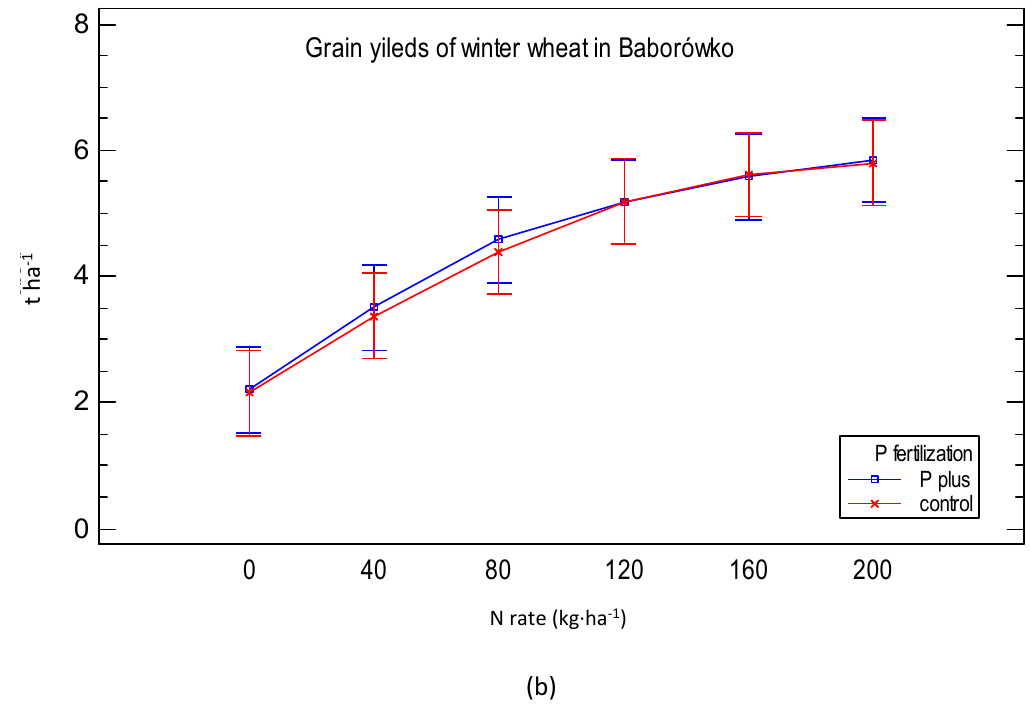
Figure 6. Grain yields of winter wheat at increasing additions of N fertilizer at the P-plus and control levels of P; 95% Tukey HSD intervals; n = 384 for each location; (P fertilization ( a ) Grabów HSD 0.550, ( b ) Baborówko HSD 0.568).